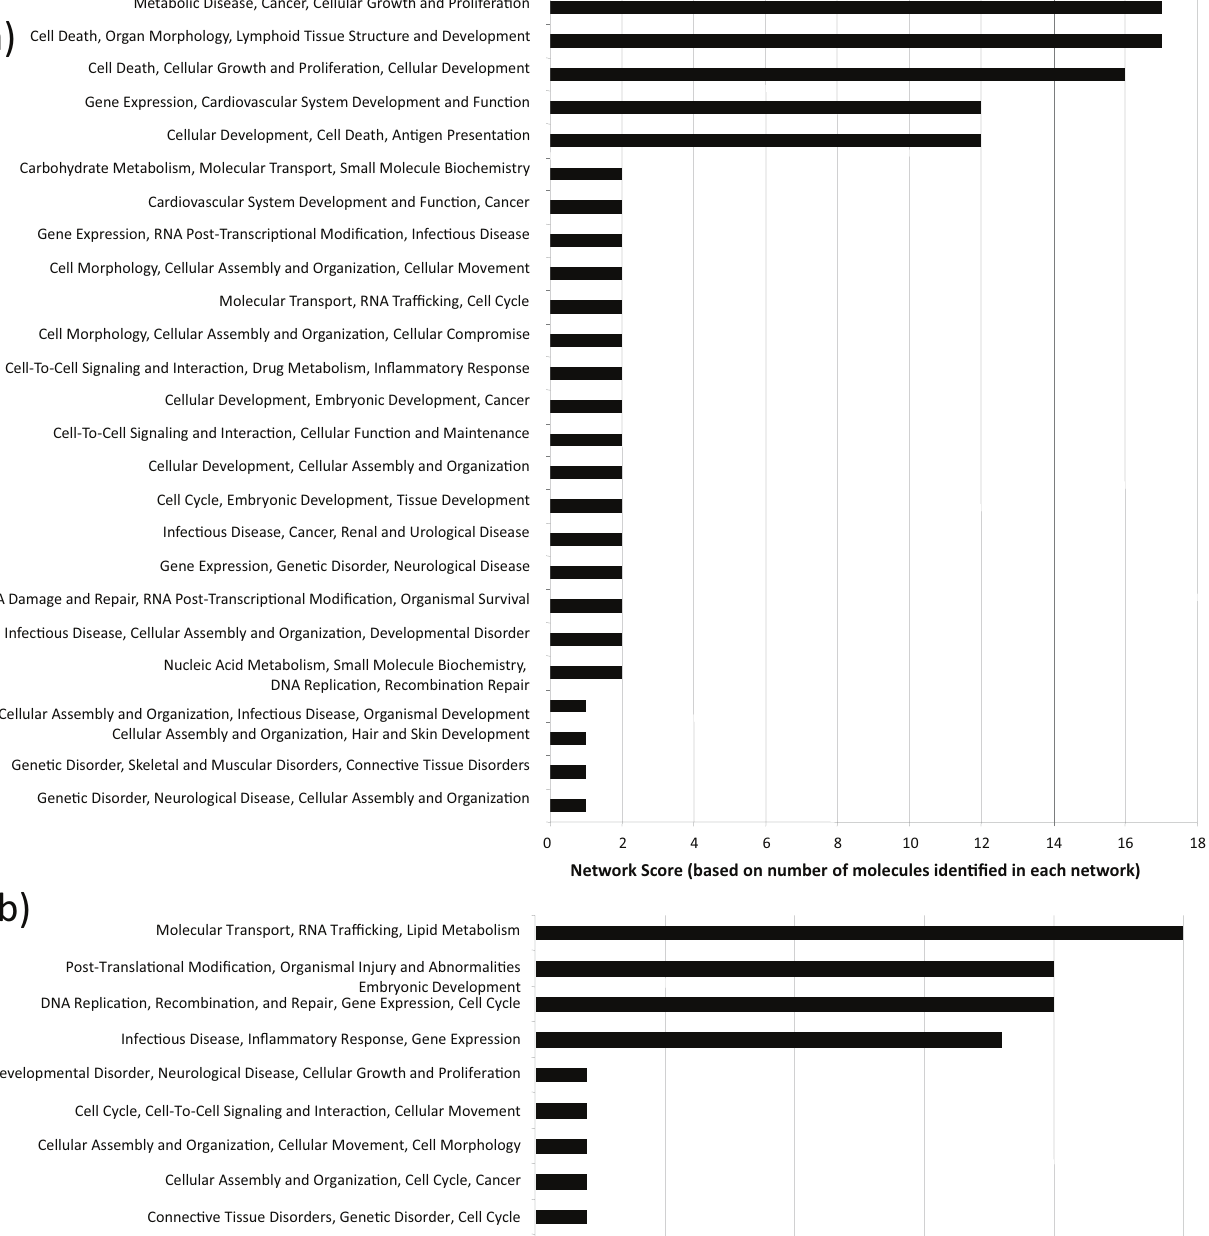
Degrada(cid:2)onAuditory DisorderDNA Replica(cid:2)on, Recombina(cid:2)on, and Repair, Post-Transla(cid:2)onal Modifica(cid:2)on Protein DisorderCell-To-Cell Signaling and Interac(cid:2)on, Cellular Func(cid:2)on and Maintenance Gene(cid:2)c Gene Expression, Cardiovascular Disease, Developmental Network Score (based on number of molecules iden(cid:2)fied in each network) Figure 5. Top network functions generated using Ingenuity protein analysis for HEK293 cells infected with T1L reovirus at (a) 6hpi and (b) 24hpi. Graphs represent host cell functions with highest score (x-axis) based on the number of differentially regulated proteins observed in that network. The higher the score, the greater the number of proteins differentially regulated in that particular function network. doi:10.1371/journal.pone.0051939.g005 PLOS ONE |